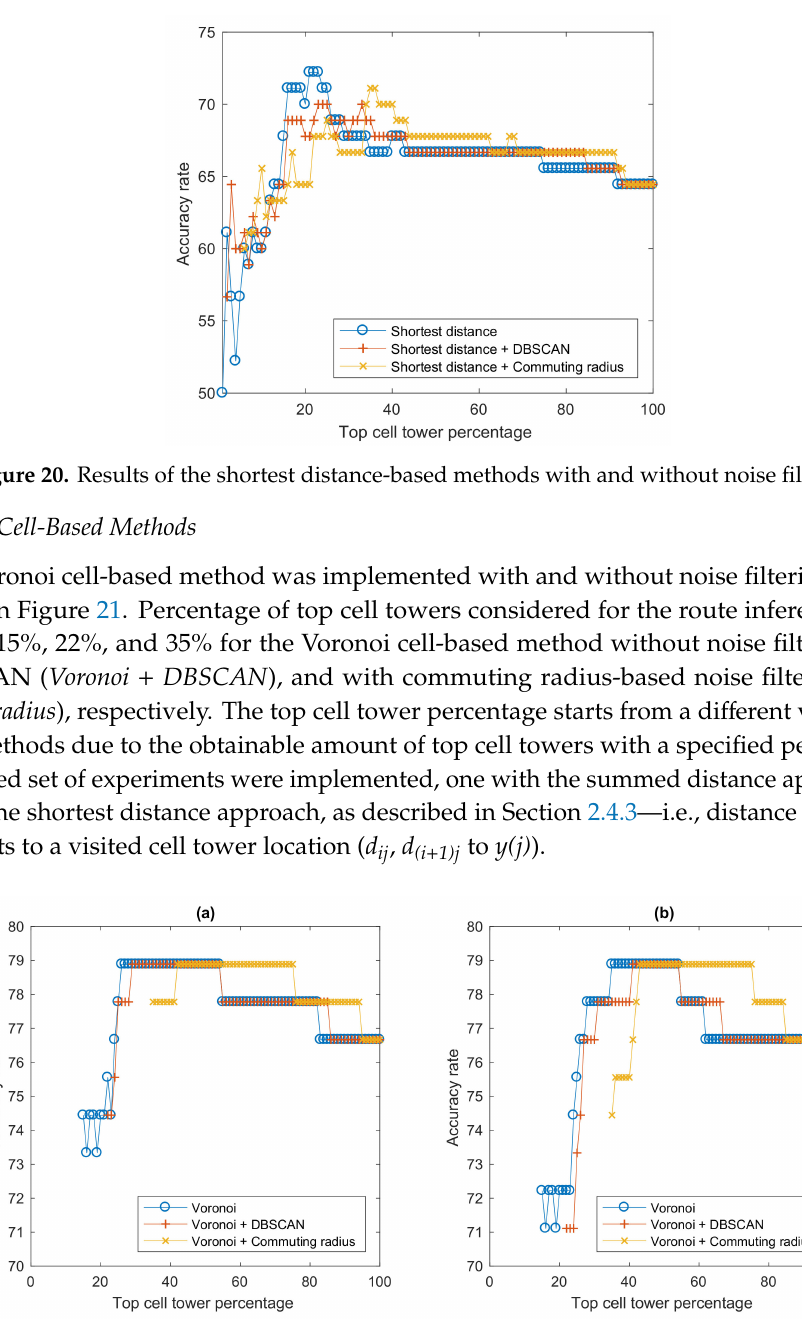
Figure 21. Results of the Voronoi cell-based methods with and without noise filtering: ( a ) summed distance approach; ( b ) shortest distance